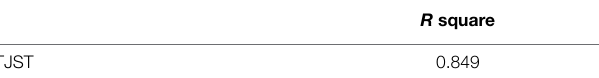
TABLE 4 | R -square.